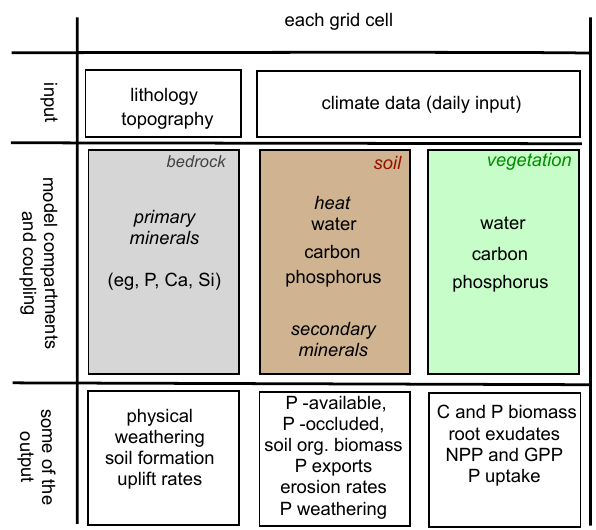
Figure 3. Diagram of the model structure (after Porada et al., 2010). The model uses daily climate data, topography and lithological classes as input. It has three main components – bedrock, soil and vegetation in which fluxes of primary minerals from the bedrock are calculated. Vegetation dynamics drive water, carbon and phos- phorus dynamics. The model calculates e.g. weathering rates, gross primary productivity and biomass production. For an extensive list of the model outputs see Table